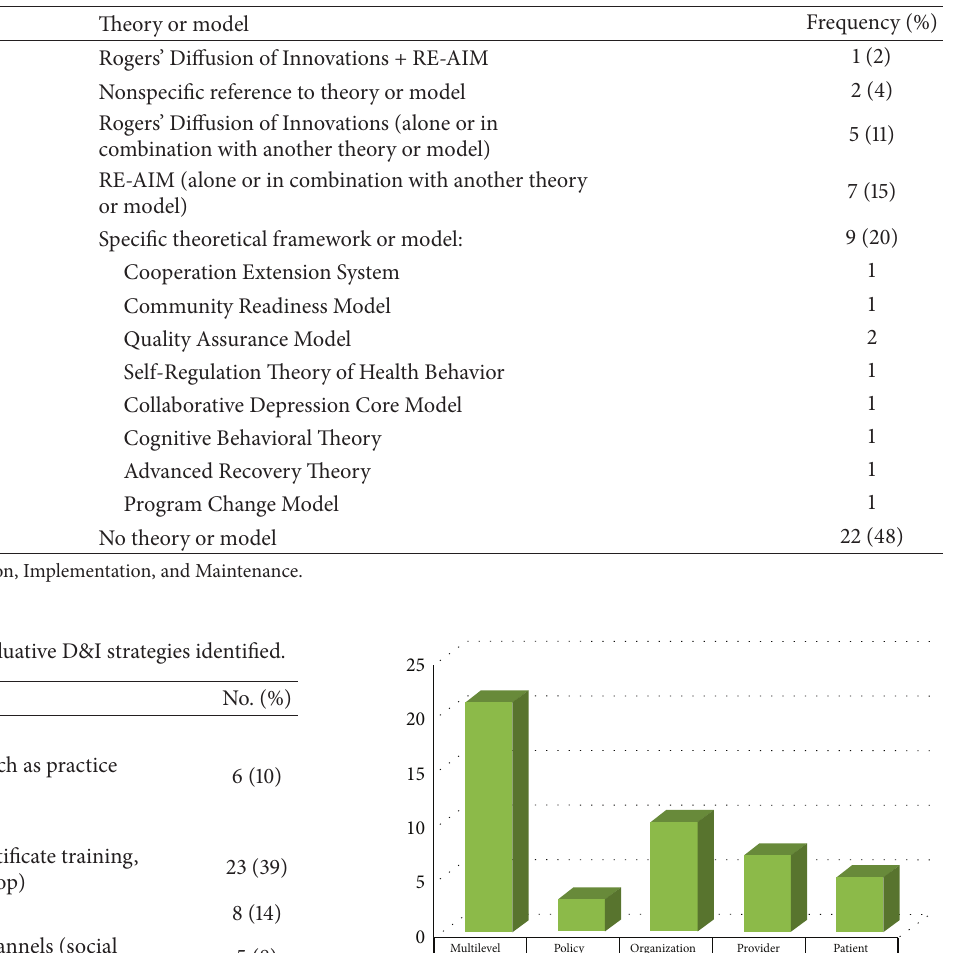
Table 3: Theories or models utilized in the R01 abstracts.